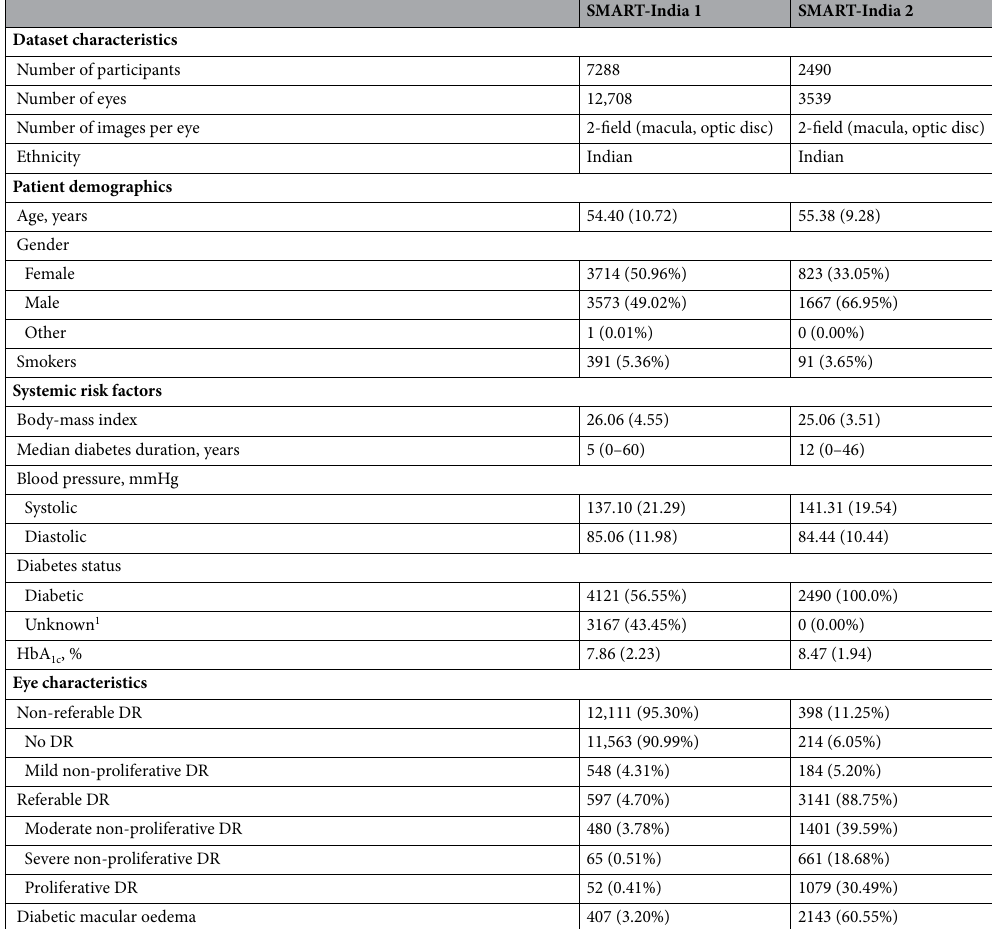
Table 1. Summary of data characteristics. 1 Random blood sugar > 160 mg/dl and HbA1c > 6.5% at